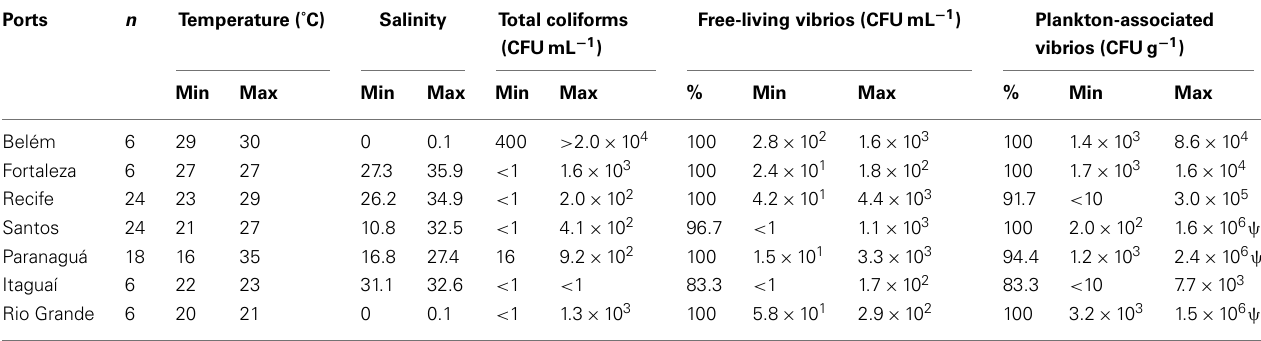
Table 2 |Temperature, salinity, total coliforms, and vibrio frequency and concentration in environmental samples collected in Brazilian harbor